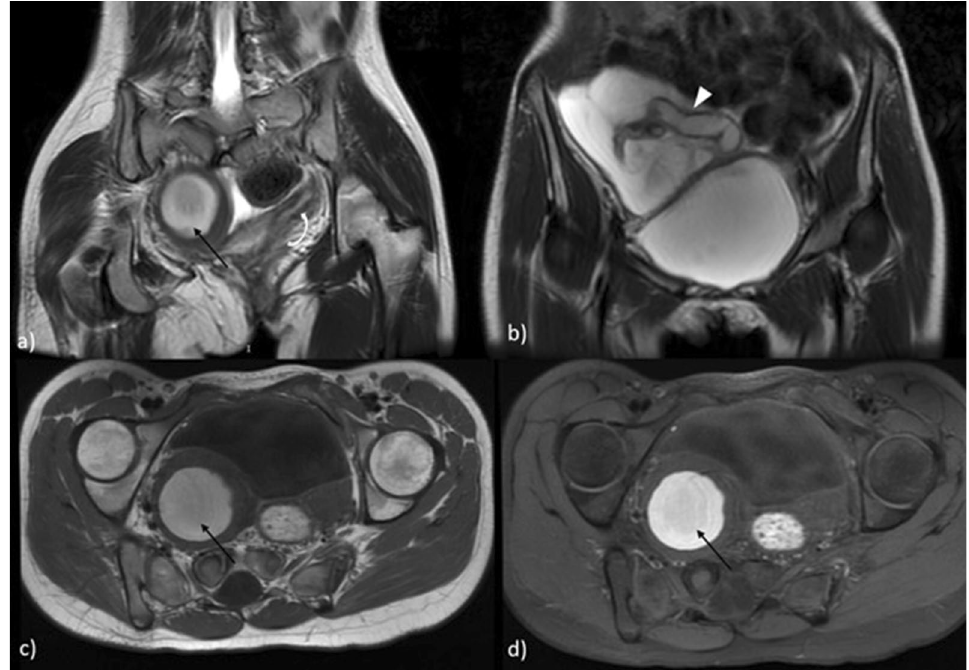
Fig. 4 MRI pelvis in a 16-year-old female presented with unresolving dysmenorrhea. Coronal T2W SE images ( a , b ) shows a small hemiuterus in the left hemipelvis (curved white arrow) with another separate myometrium-lined structure in the right hemipelvis with hyperintense contents (black arrow) within the lumen. A dilated tortuous right fallopian tube (white arrowhead) with hematosalpinx (confirmed on T1W images—not shown in image) is seen. Axial T1 SE image ( c ) and axial T1 FS ( d ) shows hyperintense contents within the structure in right hemipelvis suggesting a rudimentary horn with hematometra (black arrow). Features are consistent with a hemiuterus with a non-communicating, functional, rudimentary right horn